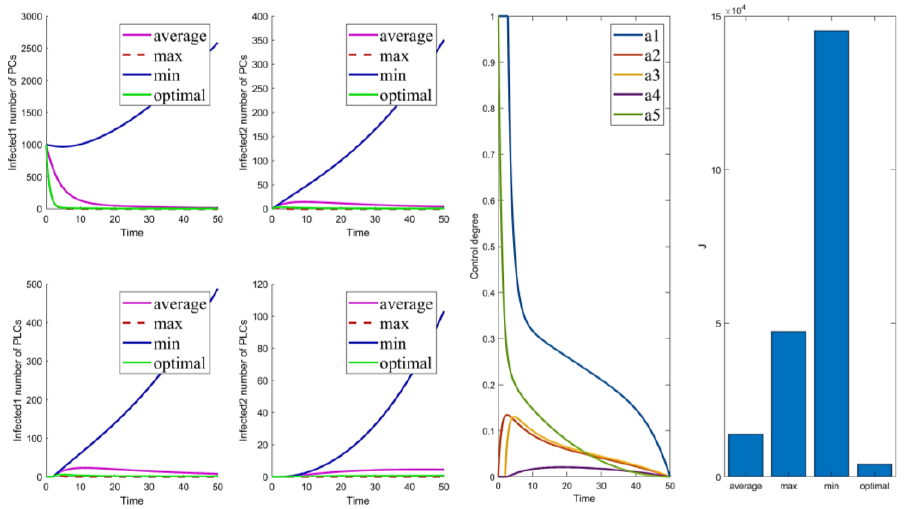
Figure 7. Solution of the optimal control strategy for Case 31 (removing average constant).